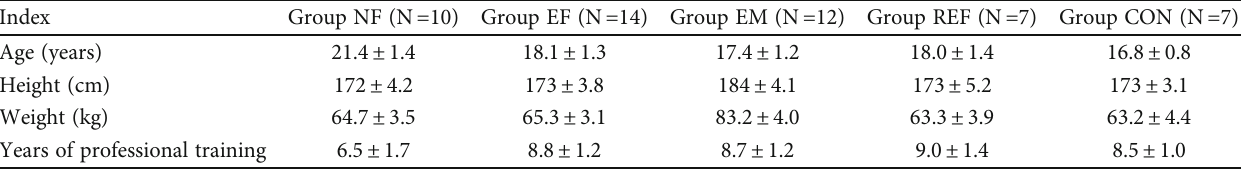
Table 1: General data of subjects (M ± SD).